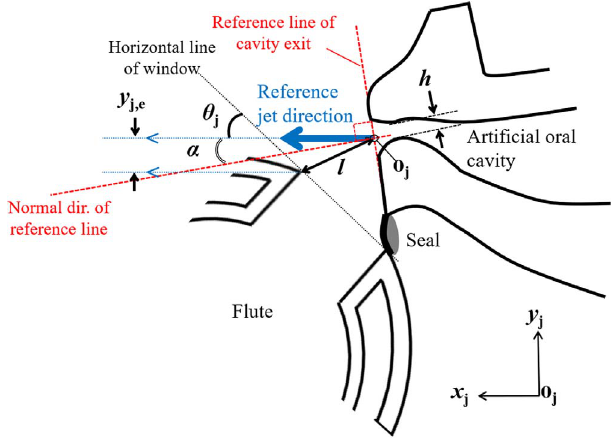
Figure 2. Schematic of blowing parameters with reference jet